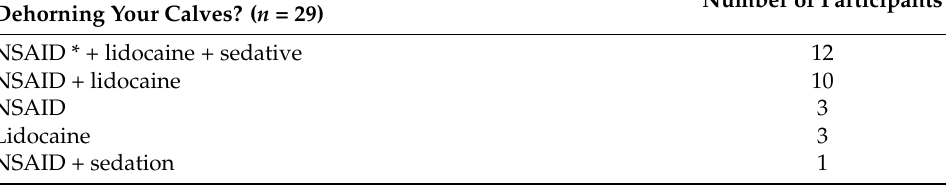
Table 2. A description of the medications used by 29 Ontario farmers for the disbudding and dehorning of dairy calves. This table is included for reference and to provide additional context to the reader. In total, an NSAID (meloxicam) was used by 26 participants, a local anaesthetic block (lidocaine) was used by 25 participants, and 13 participants used a sedative. Twenty-two participants were in full compliance with proAction requirements for disbudding (NSAID + local anaesthetic at